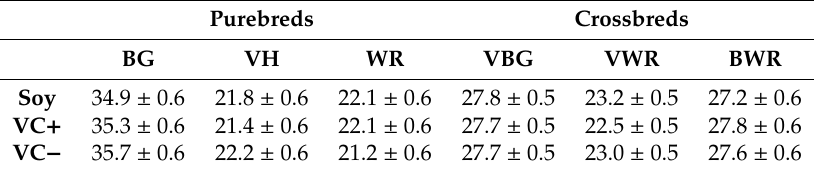
Table 3. E ff ect of feeding treatment on the daily weight gain (in g).